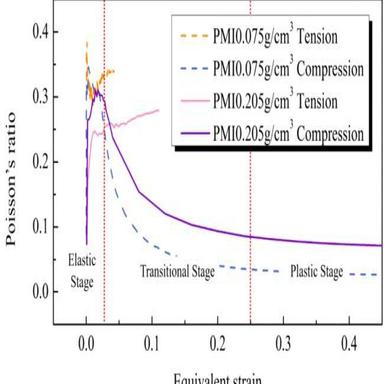
The Poisson's ratio of PMI foam with different densities under tension and compression tests. Under tensile load, the Poisson's ratio of PMI foam with 0.075 g/cm3 is obviously higher than that of PMI foam with 0.205 g/cm3 . Under compressive load, Poisson's ratios for PMI foam with densities of 0.075 and 0.205 g/cm3 are quite close in elastic stage.